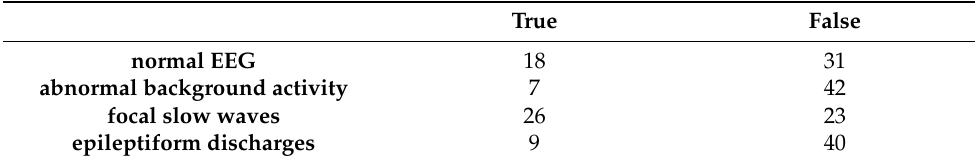
Table 6. Clinical characteristics of the patients–EEG at